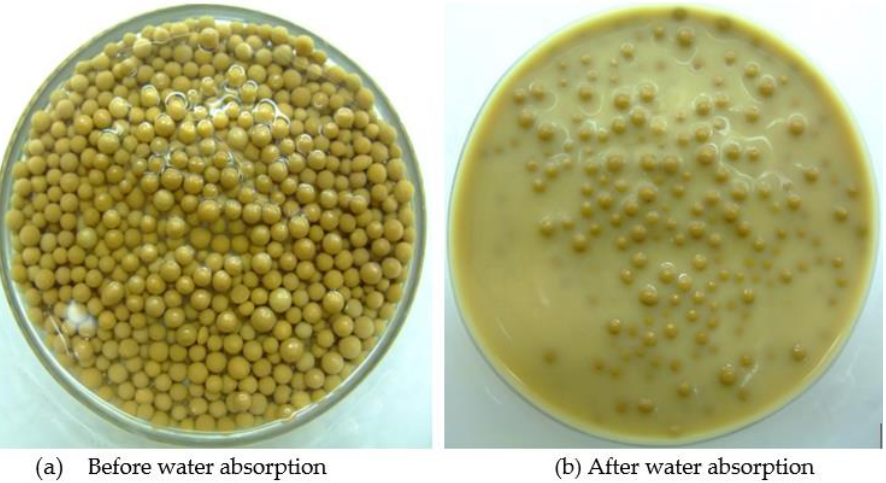
Figure 2. A comparison of the appearance of molecular sieves ( a ) before water absorption and ( b ) after water absorption from palm oil accompanied by electromagnetic stirring.